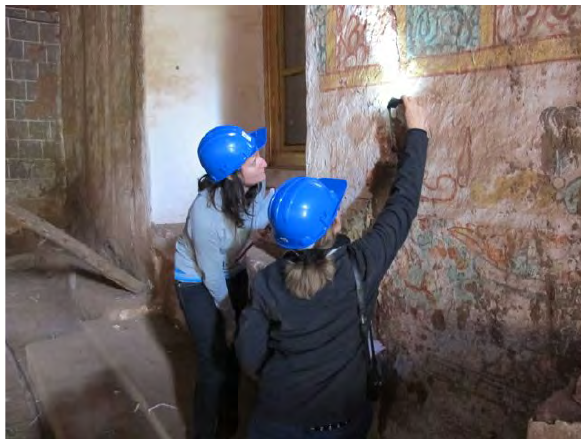
Figure 4. Plan of the church of Kuno